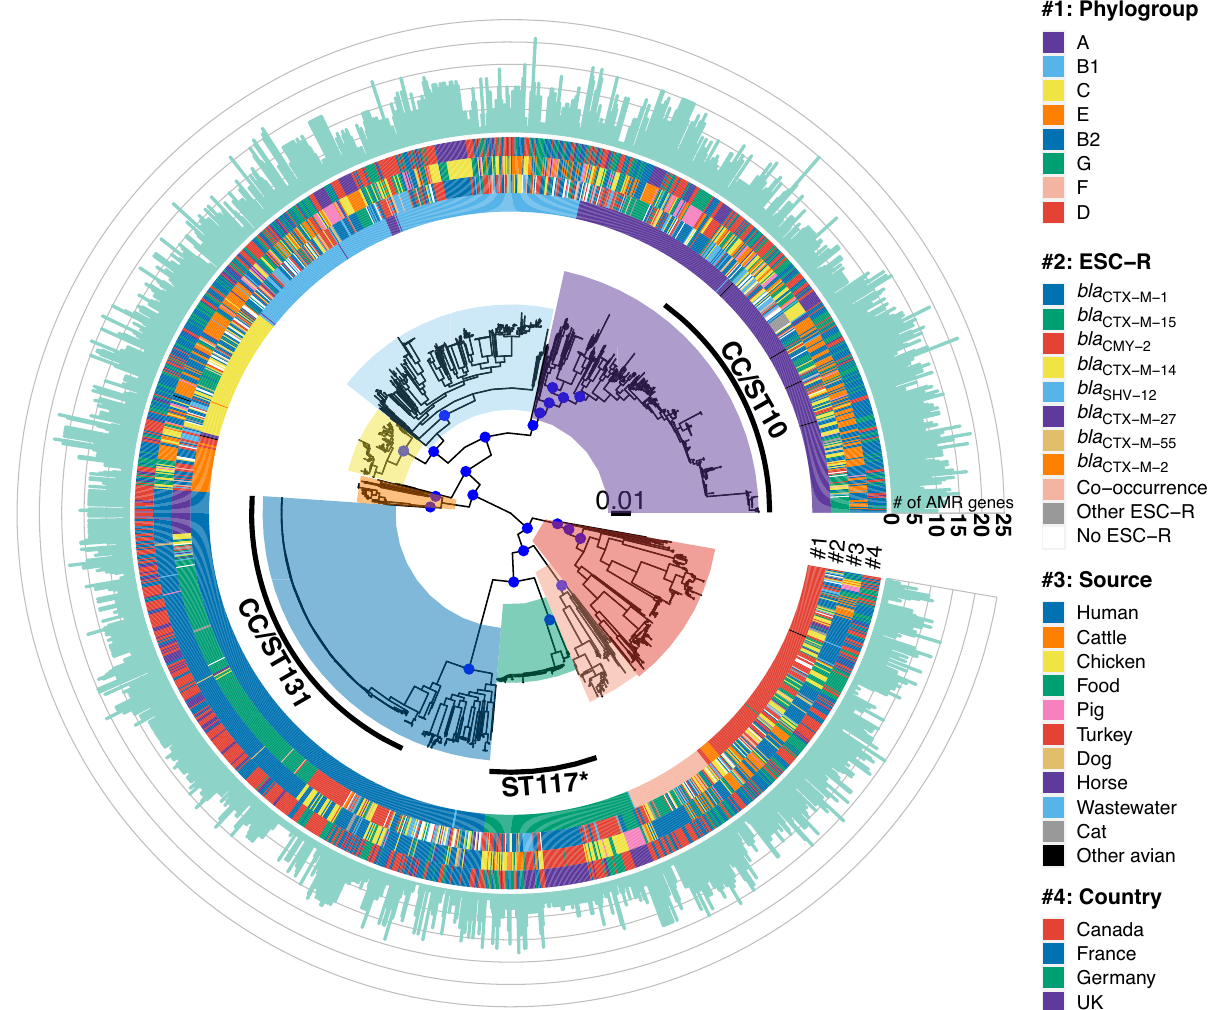
Fig.4|Core-genephylogenetictreefor1818 E.coli isolates. Maximumlikelihood treewitheightmainclusterslinkedwithphylogroup.Bootstrapsupportvalues>95 are represented by blue dots for main clusters. Metadata are represented next to thetreebyfourrings:phylogroup,ESC-Rgene,sourceandcountry(colouredasper